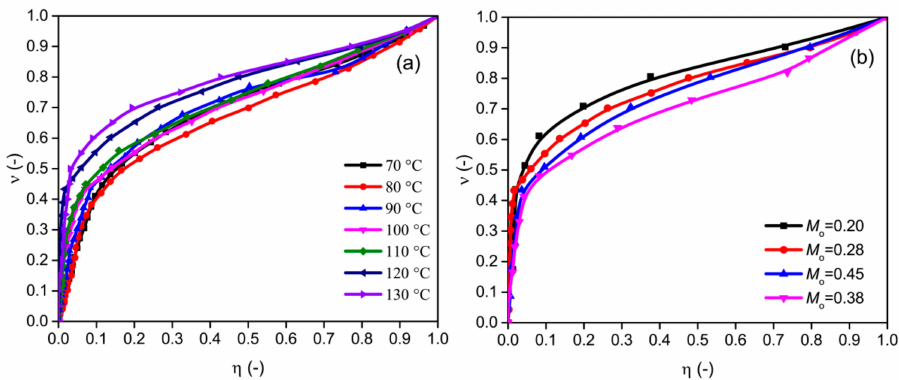
Figure 9. Normalized single particle drying curves: ( a ) for different drying temperatures; ( b ) for different initial moisture